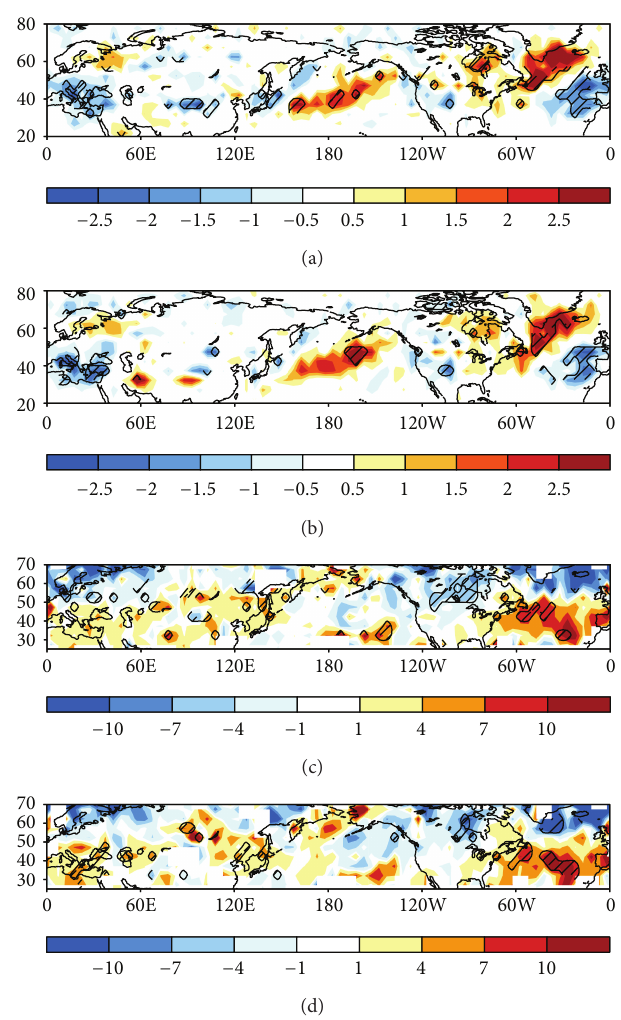
Figure 2: NH winter (JFM) NAO positive-NAO negative cyclone track frequency composite for (a) NCEP1 5801, (b) like (a) but for ERA40 5801. Units: no. of cyclones per 5 ∘ Lat × 5 ∘ Lon box. Hatched areas are significant at 90% for 2-tailed 𝑡 -test. (c) NH winter (JFM) NAO positive-NAO negative cyclone track intensity composite for NCEP1 5801. (d) like (c) but for ERA40 5801. Units: hPa. Hatched areas are significant at 90% for 2-tailed 𝑡